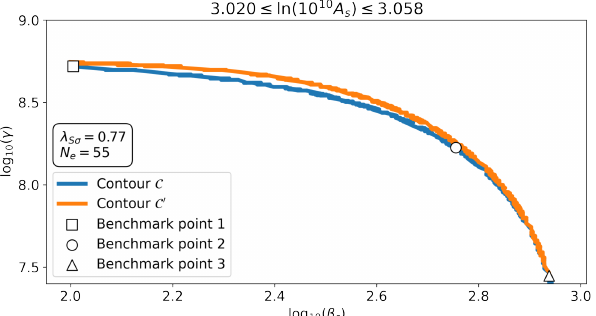
Figure 10 . The lines indicate the parameter combinations of γ and β S for which the scalar power spectrum amplitude A s prediction is fixed to the Planck constraint (4.24) for the two inflationary contours defined in eqs. (4.11) and (4.18). For all points we have fixed β σ = 1 and λ S = 0 . 005 . The three benchmark points defined in table 1 and displayed in figure 7–9 are marked.